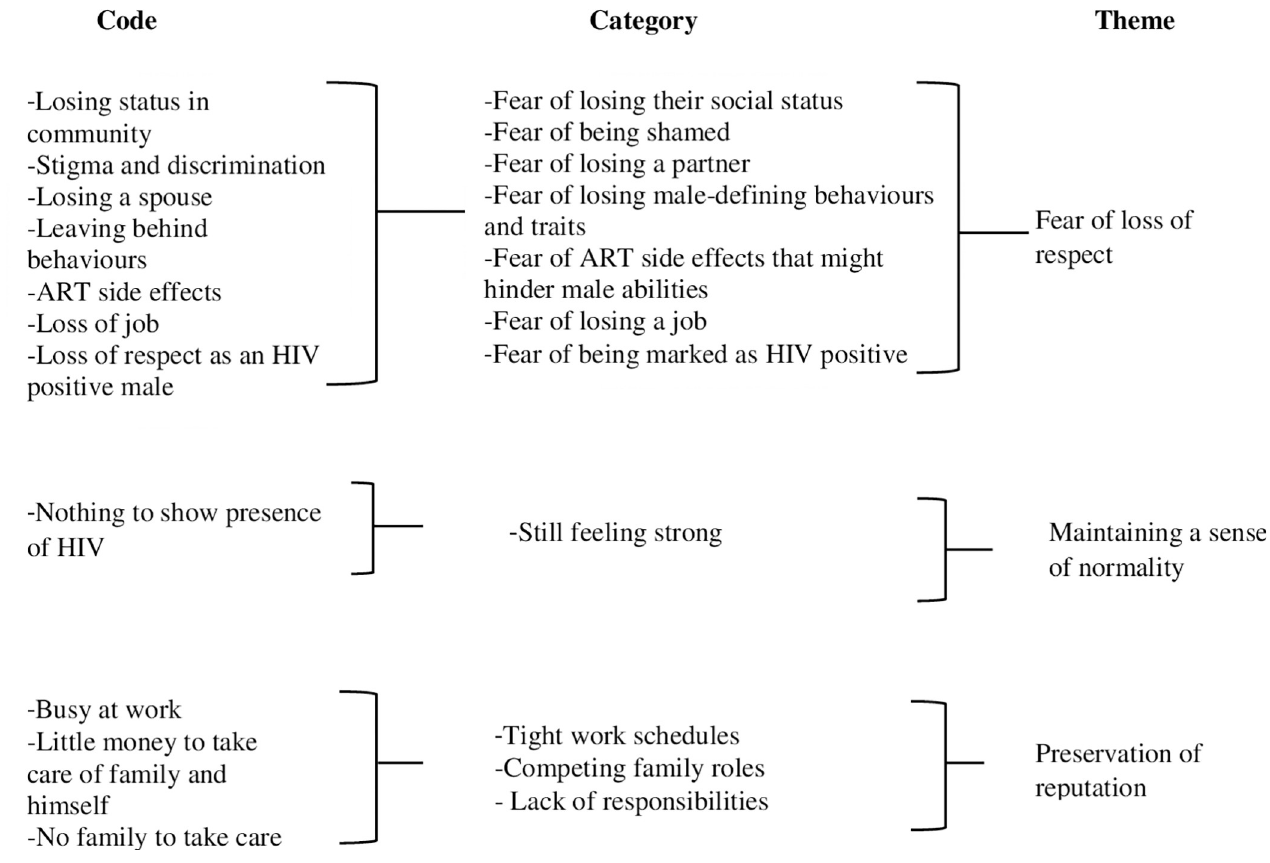
Fig 1. Data analysis